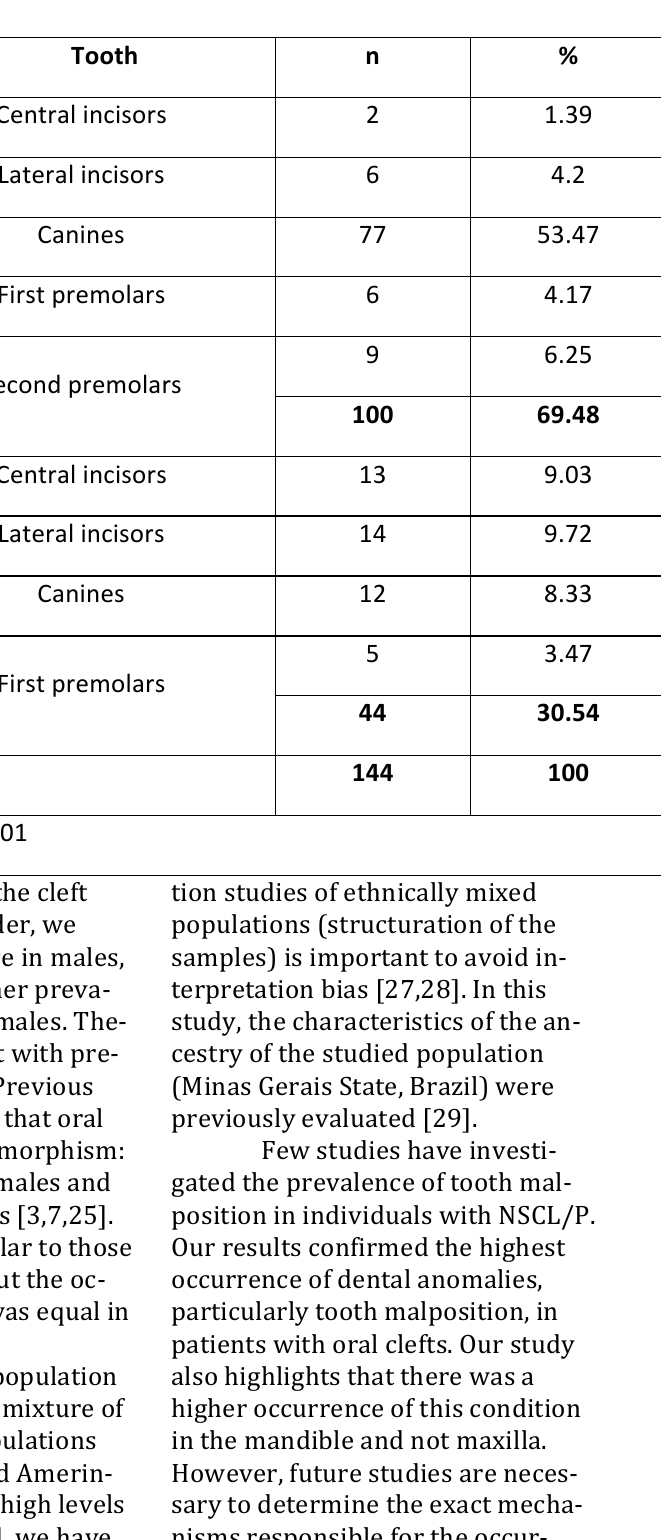
Table 3. Frequency of malposition according to type of tooth in individuals with oral